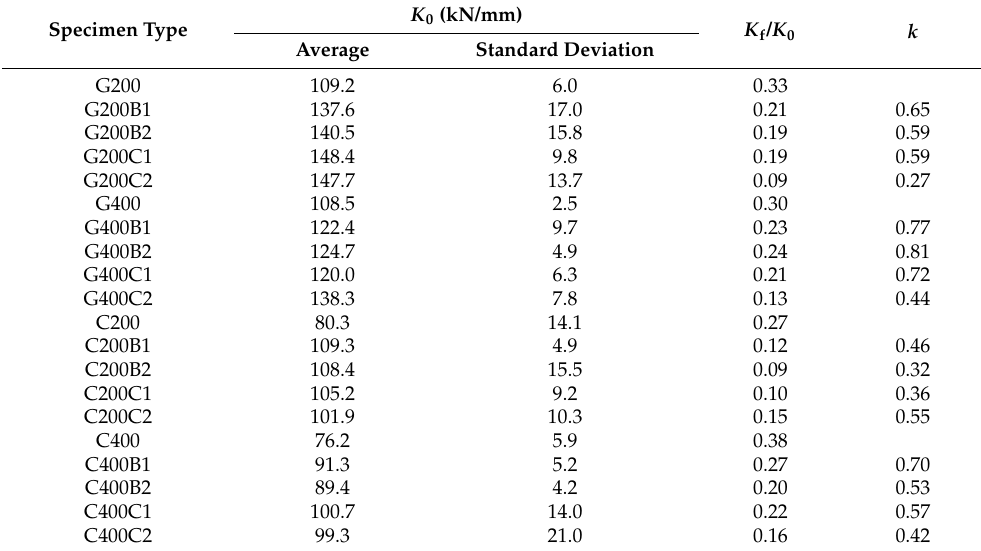
Table 4. Initial stiffness in the cyclic